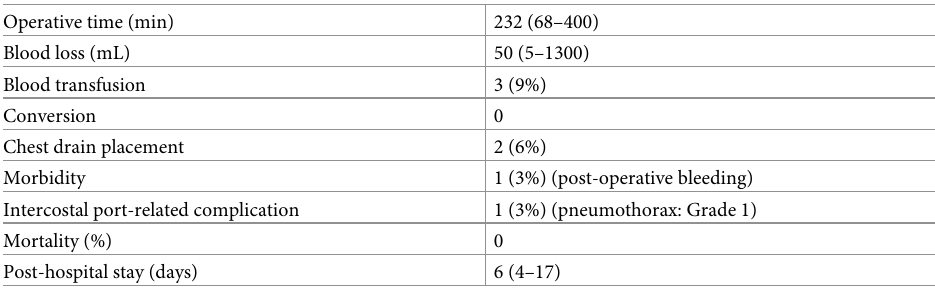
Table 2. Surgical outcomes (N =